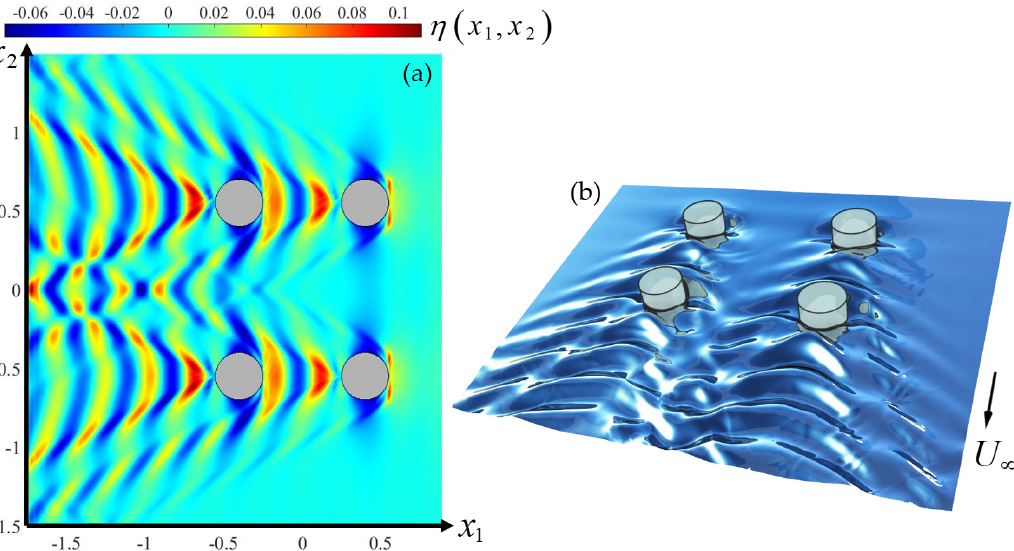
8 of 25 Figure 4. ( a ) Color plot and ( b ) rendered view of the free surface elevation generated by the steady perturbation field for one cylindrical scatterer of diameter